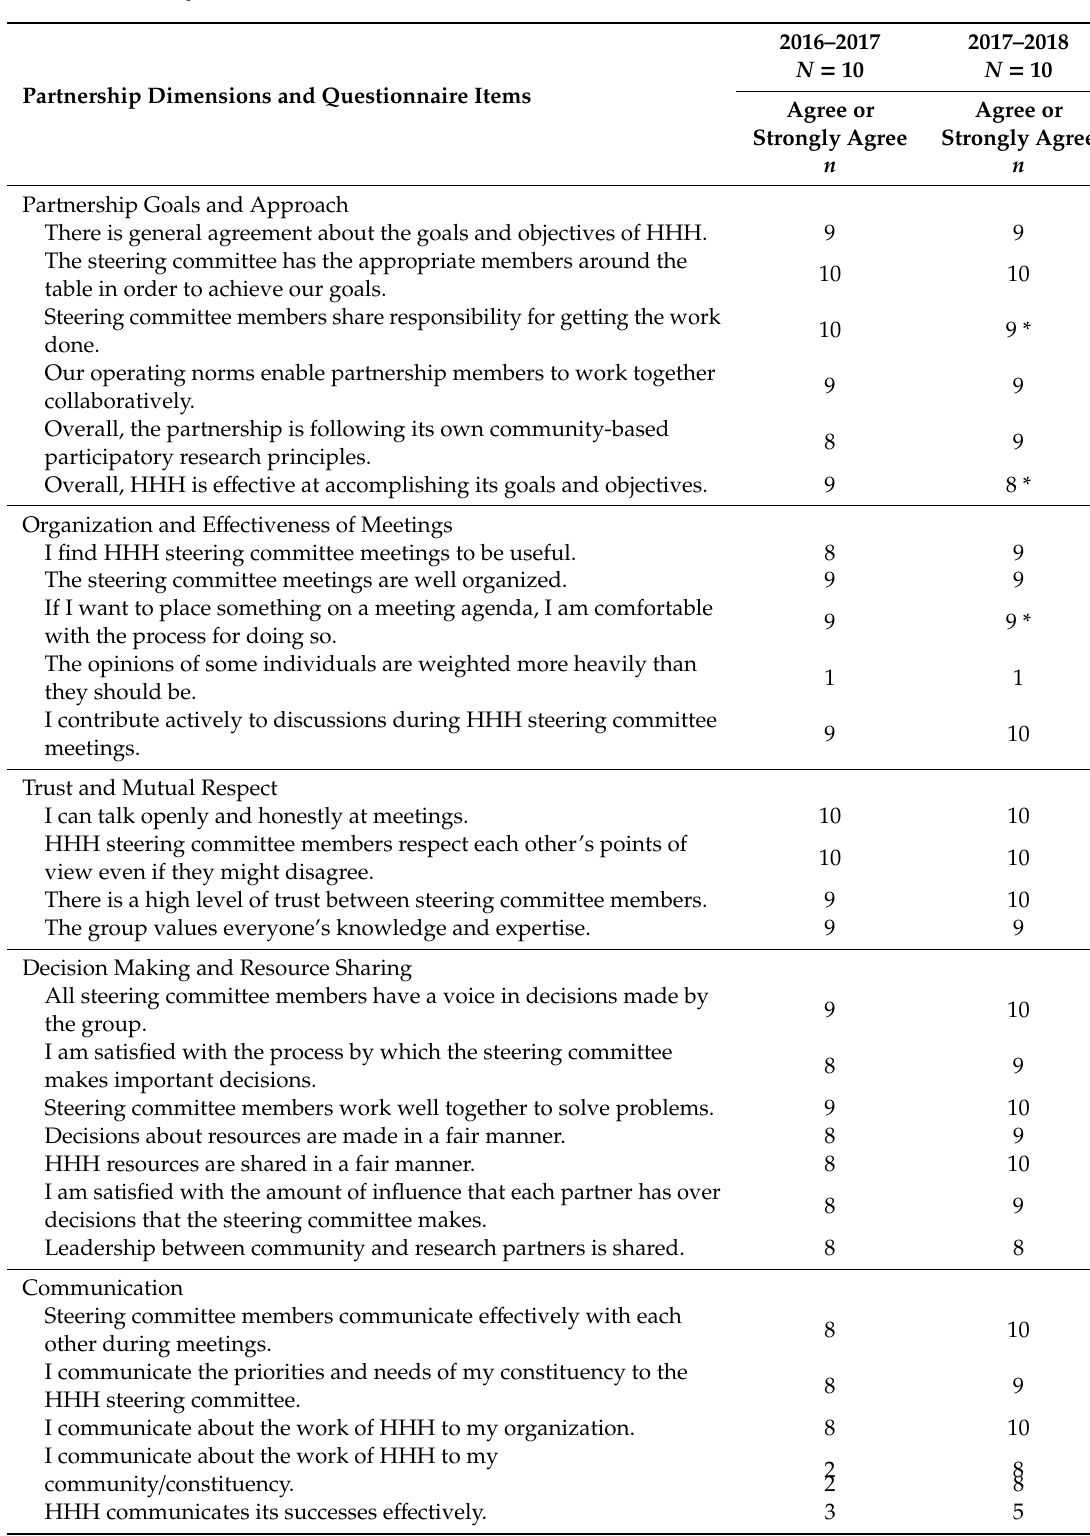
Table 1. HHH CBPR partnership dynamics and e ff ectiveness: Results from the HHH Partnership Evaluation Questionnaire Years 1 and